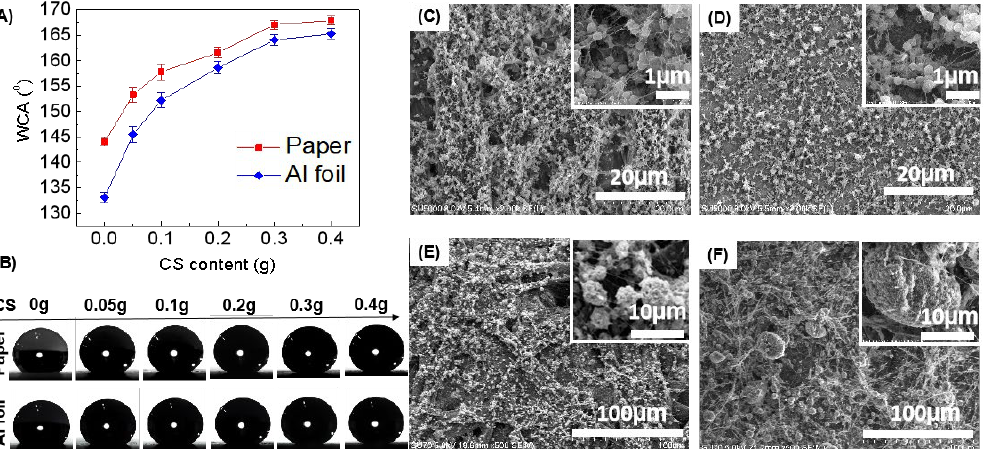
Figure 1. Effect of CS content on the hydrophobicity and surface morphology of electrosprayed paper and Al foil substrates: ( A ) water contact angle (WCA) varied with CS content; ( B ) typical WCA photos of the curves from ( A ) (the arrow indicates the increasing direction of CS content); ( C – F ) SEM images of electrosprayed samples with CS contents of 0 g and 0.3 g on paper ( C , E ) and Al foil ( D , F ), respectively (insets are the enlarged images of each samples).